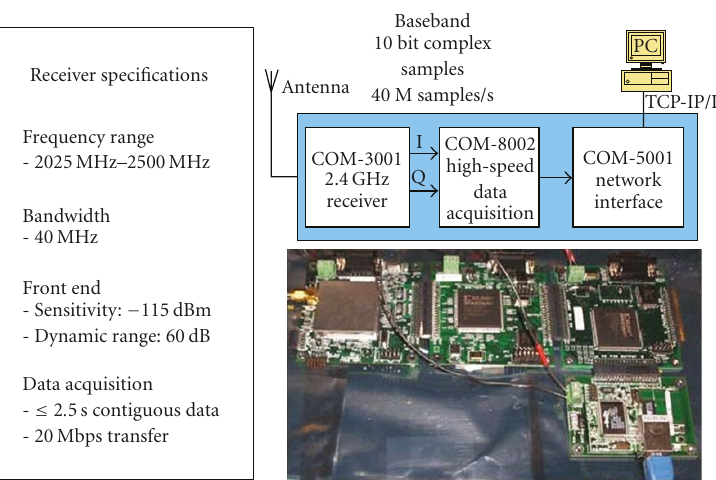
Figure 1: Measurement